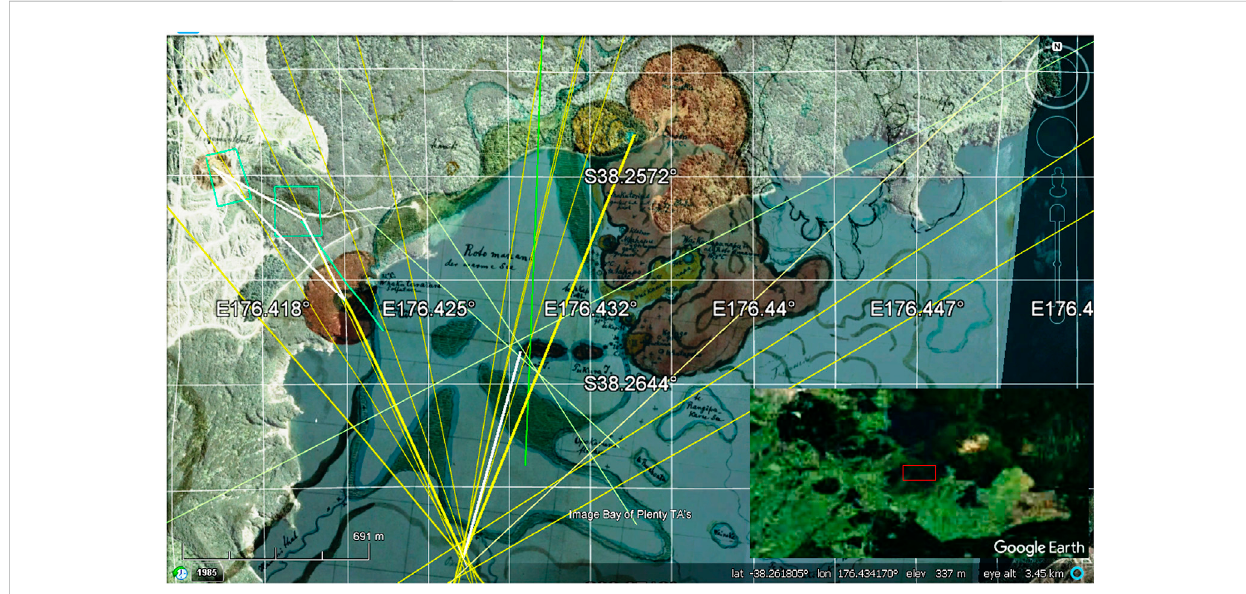
FIGURE 16 Our published iteration V – VI Pink Terrace spring location, lying along the same section of the crater rim in Figures 12, 15. (Bunn, 2019b). Hochstetter ’ s Pink Terrace spring bearing (in bold yellow) also strikes this spot, con fi rming Warbrick ’ s location. His White Terrace bearing (in bold yellow) also strikes the White spring. The overview map marks the location in the northern Taup ō Volcanic Zone. Note that the survey stations and bearings in Figures 9, 16 were resected on different computers to replicate the fi ndings. Refer to Figure 1 for more location details.